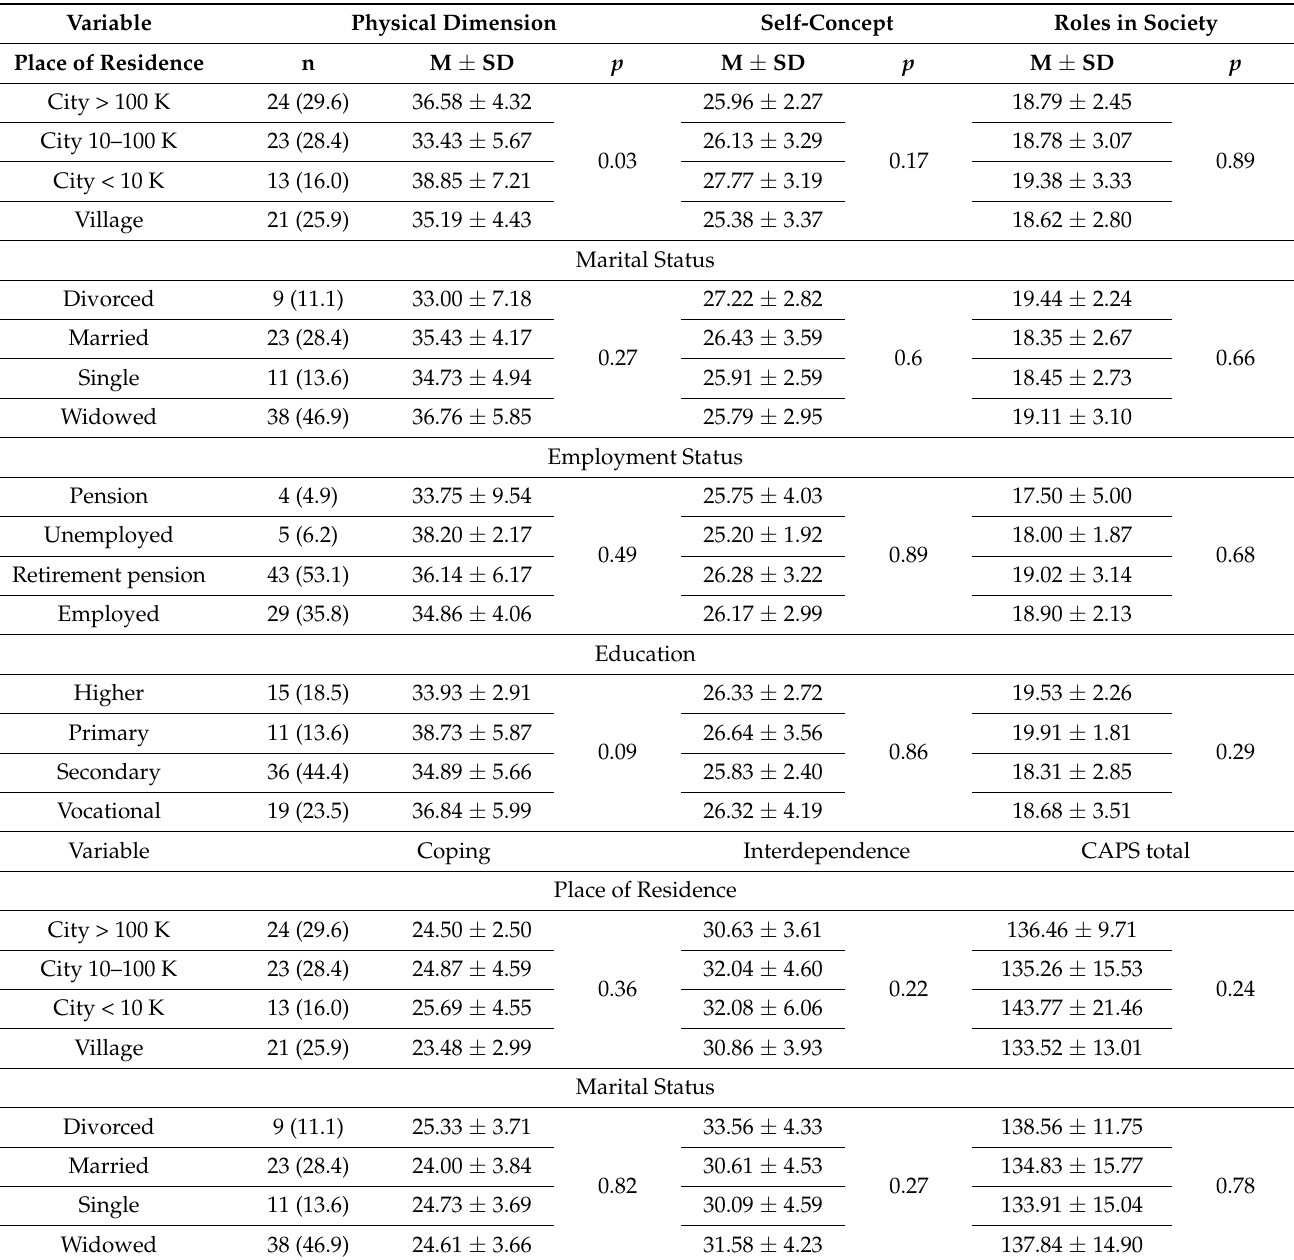
Table 6. CAPS results and sociodemographic